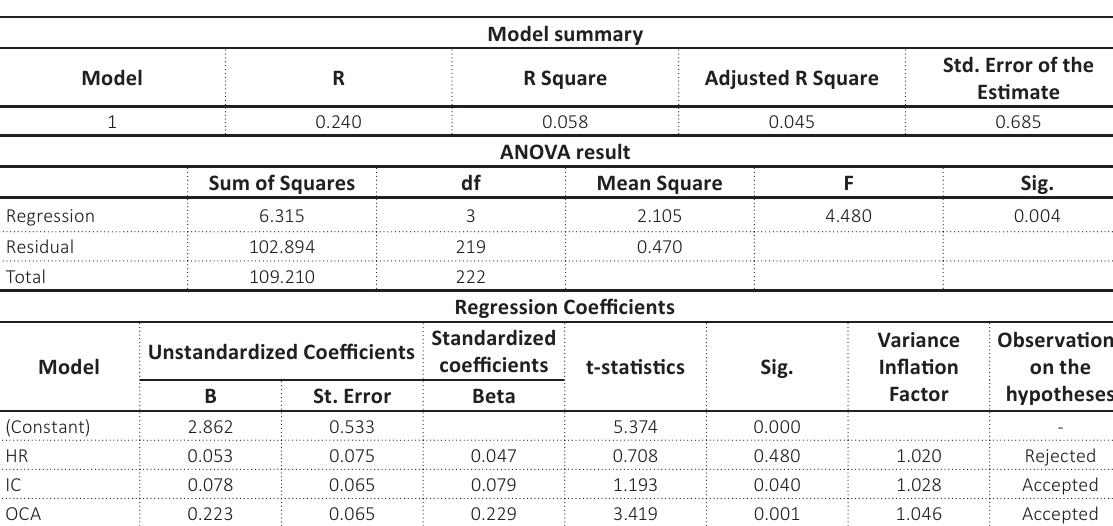
Organizational Culture Figure 2. The outcome of the standardized hypothesized paths Table 6. Regression insights